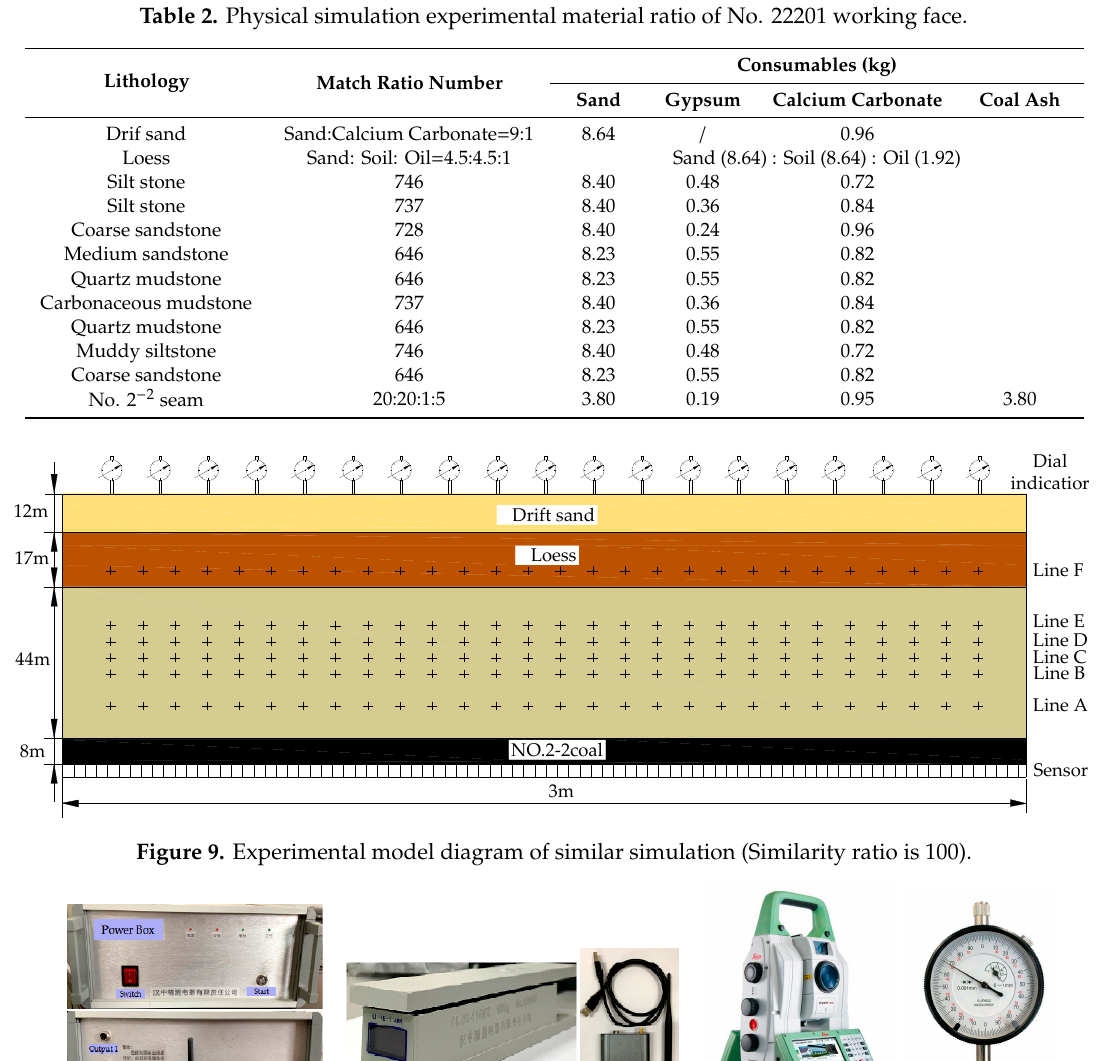
Table2. Physical simulation experimental material ratio of No. 22201 working face.